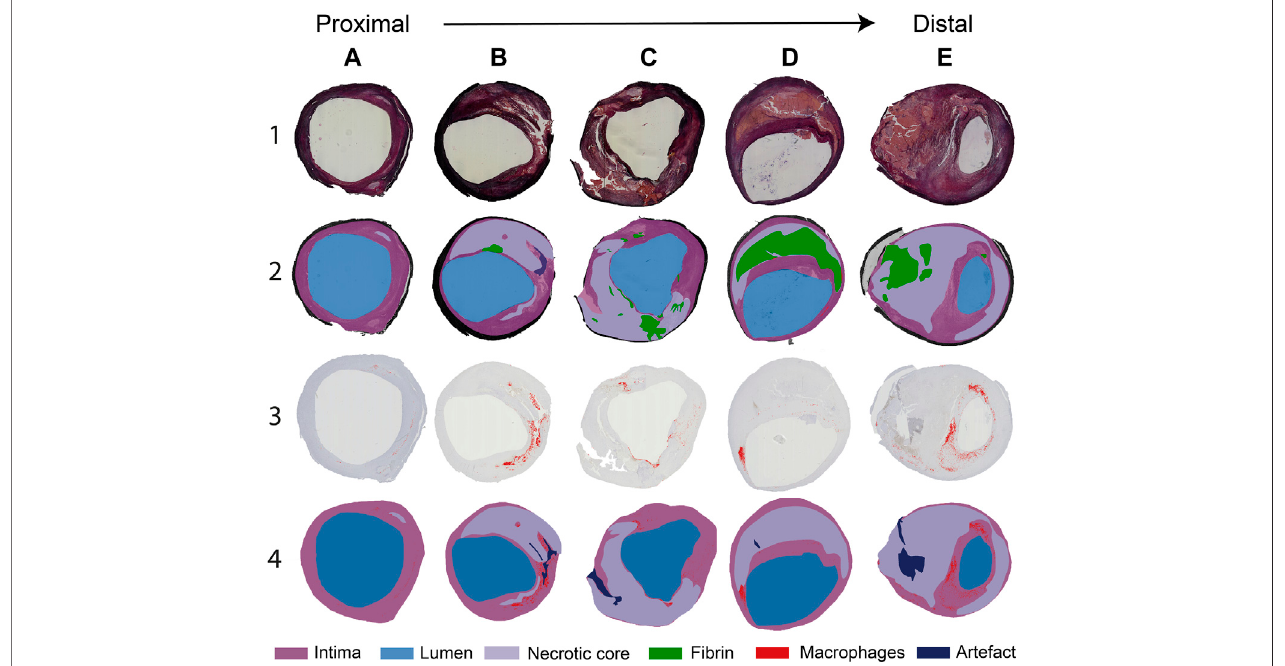
FIGURE2|(A – E) .Selectionoftypical histologycross-sections ofcarotidplaques seenwhen moving from proximal todistalalongthe lengthofthecarotidplaque. Cross-sections (A – C) areseenproximaltothe fl owdividerand (D,E) distaltothe fl owdivider.Row1:Miller ’ selasticstain.Row2:segmentationofthenecroticcore(NC), fi brin, and artifact, based on the combination of histochemical staining procedures performed. Row 3: CD68 + immunohistochemical stain. CD68-positive areas are marked in red. Row 4: segmentation of CD68 + stained slides, showing macrophage areas, NC, and artifacts.